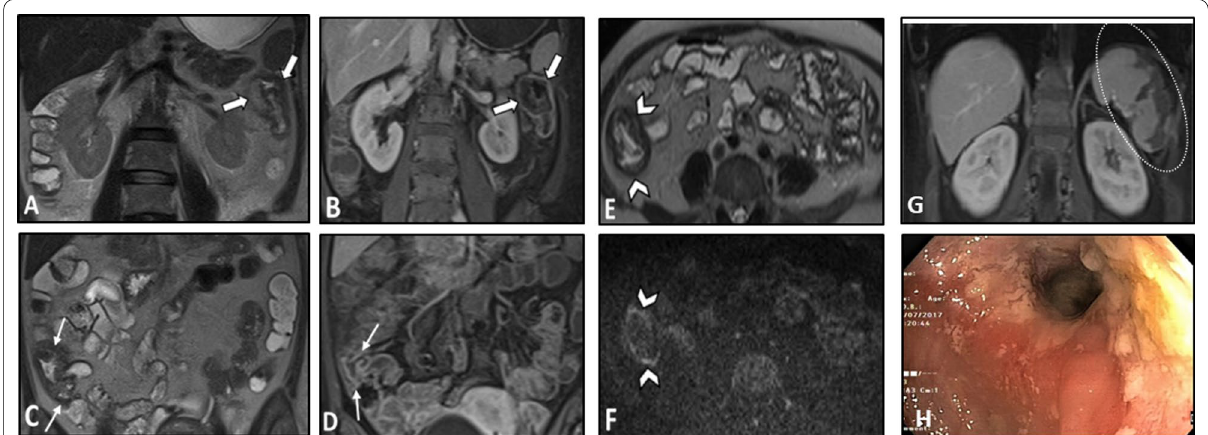
Fig. 14 Intestinal ischemia in a 31-year-old female with known SLE-Sjögren overlap syndrome presenting with fever, anemia, and LUQ pain. MRE was obtained. Coronal T2-W and post-contrast T1-W images ( A , B ) display mural thickening, mucosal hypoenhancement, and serosal hyperenhancement of descending colon adjacent to the splenic flexure (thick white arrows) suggestive for mucosal ischemic changes. Coronal T2-W and post-contrast T1-W images ( C , D ) display mural thickening and increased mural enhancement of the cecum and ascending colon (Thin white arrows). Axial T2-W image and corresponding DWI sequence ( E , F ) show concentric mural thickening of the proximal ascending colon, demonstrating restricted diffusion (white arrowheads), in favor of ischemic changes or increased inflammatory cells. Coronal post-contrast T1-W image ( G ) reveals subcapsular areas of splenic hypoenhancement (white dotted oval), indicative of infarction. Pale and fragile mucosa is seen in colonoscopic view ( H ) of the involved colonic splenic flexure